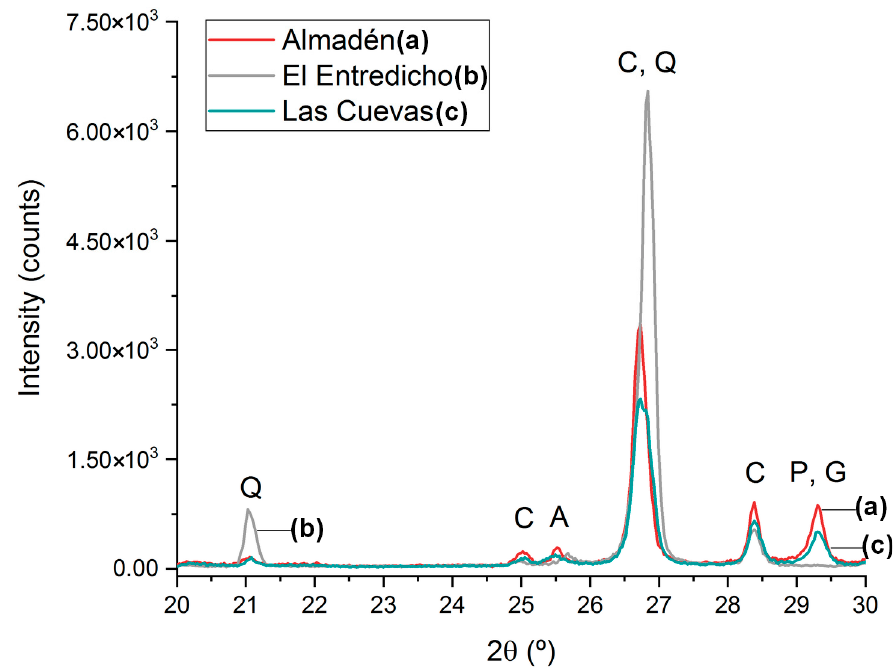
Figure 3. Diffractograms acquired on the samples of the Almad é n mining district: Almad é n ( a ), Las Cuevas ( b ) and (El Entredicho ( c ). Q: quartz, C: cinnabar, A: anatase, P: pyrophyllite, G: